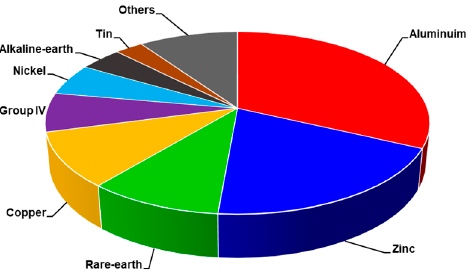
Figure 1. General scheme for the Ring Opening Polymerization (ROP) of common cyclic esters ( a ); possible microstructures of poly -lactide ( b ).